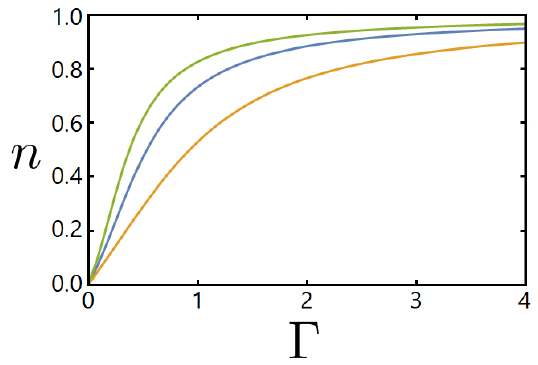
Figure 7: Total density across the junction and mean occupation number as a function = 0.1, t ( (cid:96) ) = 1 and α = 0.25 (green curve), α = 0.5 (blue curve) of Γ for γ = 3, γ C and α = 0.75 (orange curve).